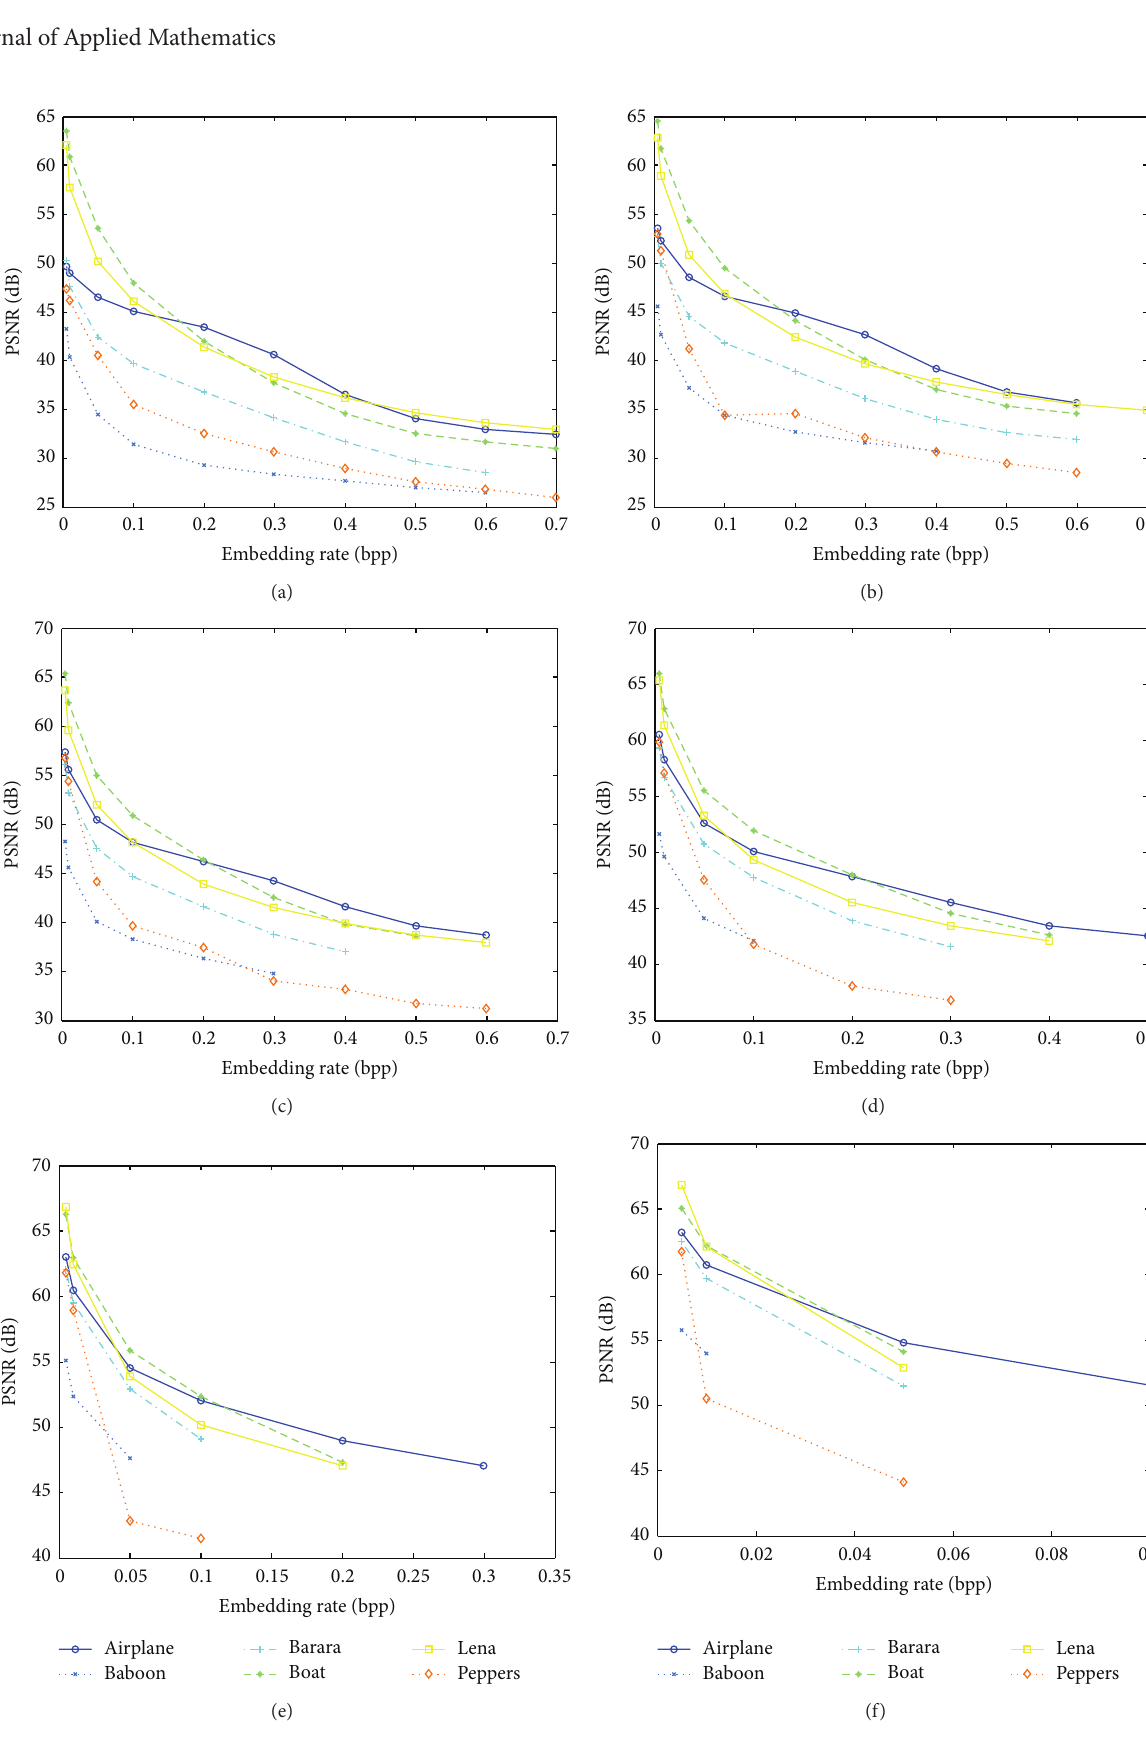
Figure 5: Embedding rate and PSNR of different images with different embedding strength